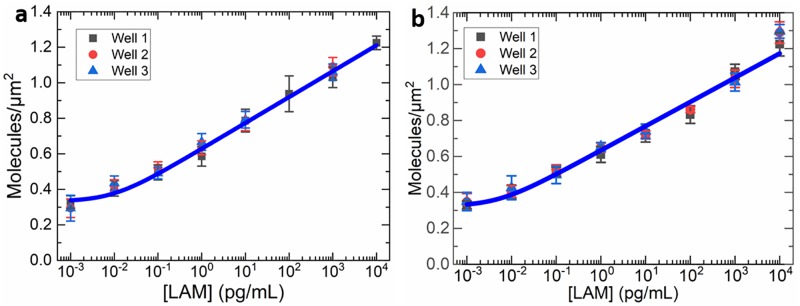
SM FLISA standard curves and fitted data for (a) Assay #1 and (b) Assay #2 demonstrating a good agreement with each other for reproducibility of the data.